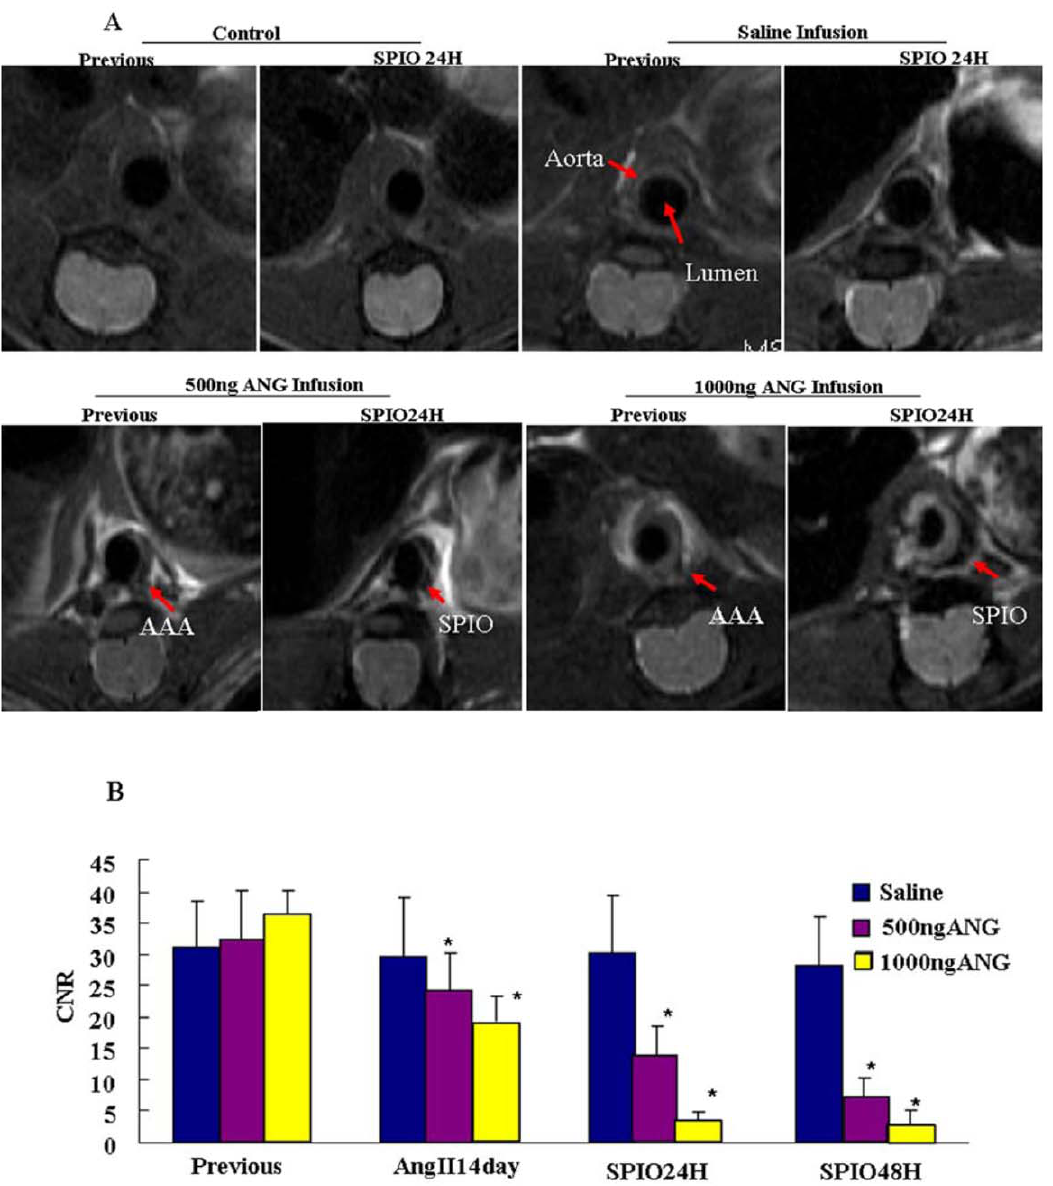
Figure 3. Representative example of T2WI of the abdominal aorta in apoE 2 / 2 mice before and after SPIO injection. (A) The abdominal aorta before SPIO contrast agent administration and the same segment of the abdominal aorta 24 h post-SPIO administration. Red arrows indicate aortic aneurysms. (B) MRI signal in the abdominal aorta of apoE 2 / 2 mice after injection of contrast agents. Values are expressed as mean 6 SEM (n=6, *P , 0.05 vs. Previous & ANG II 14D).